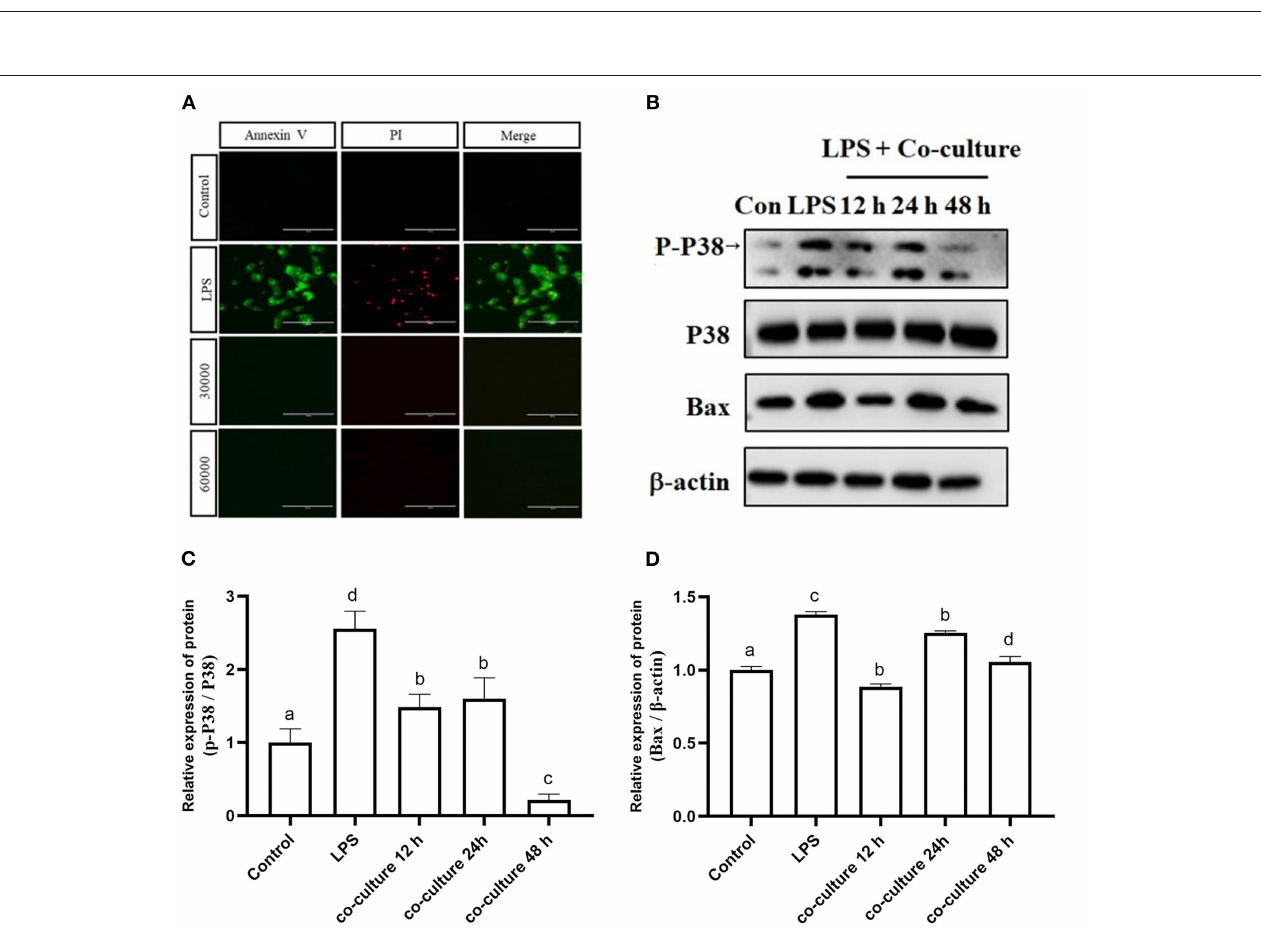
FIGURE 6 | Effects of bAD-MSCs on LPS induced apoptosis of bEECs. (A) Immunofluorescence reactions for bEEC apoptosis by Annexin V-FITC and PI. bEECs were treated with 0.1 µ g/mL LPSs for 6h, co-cultured with bAD-MSCs 30,000 cells, and 60,000 cells for 48h. The first column shows Annexin V by FITC, while the second column shows cell nuclei labeled with PI. The last column shows merged images with FITC and PI. (Scale bar = 100 µ m). (B) Western blot analysis of p38, P-p38, and Bax proteins. bEECs were treated with 0.1 µ g/mL LPSs for 6h, and co-cultured with bAD-MSCs for 12, 24, and 48h. (C) Relative protein expression levels of P-p38/p38. (D) Relative expression levels of Bax protein. Different lowercase letters in bar charts indicate significant differences ( P <